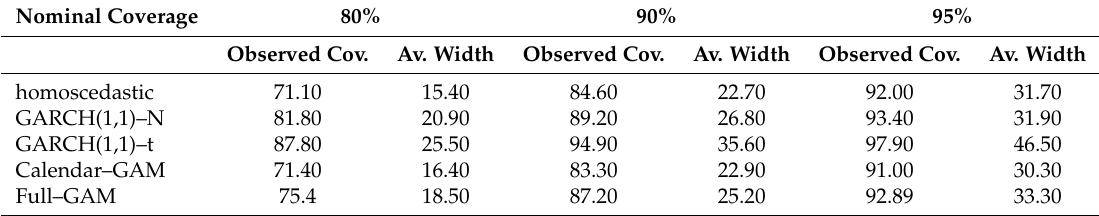
Table 7. Electricity prices for the southern zone. Out-of-sample predictive results for the year 2019. For all models the MAE is equal to 6.40 and the MAPE is equal to 22.4%, while it is equal to 11.5% if we condition to prices greater than their third empirical percentile. Moreover, “observed cov.” stands